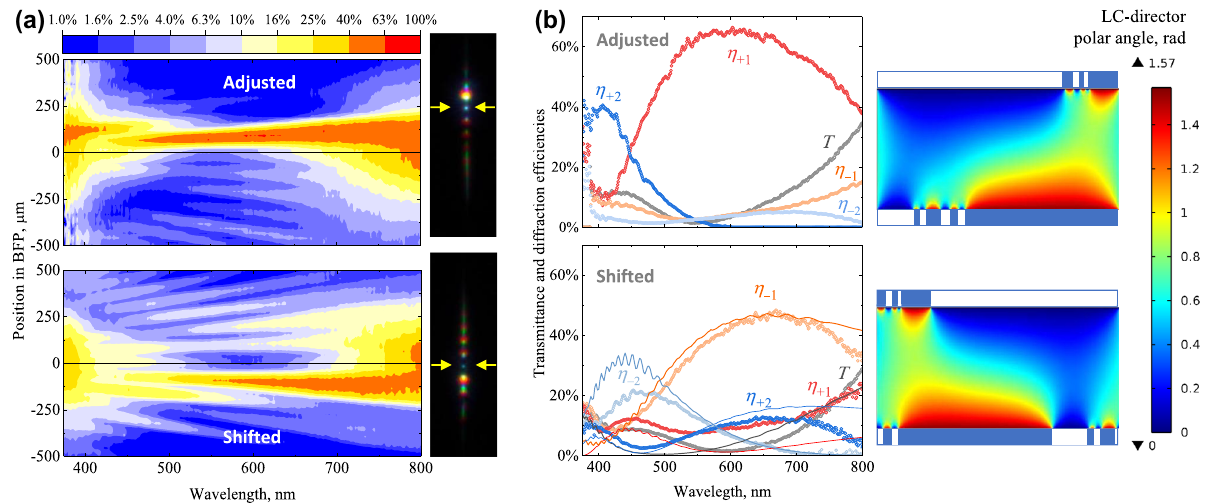
Figure 6: Mechanical tuning of the 8 μ m periodic double-sided LC-metasurface. (a) Intensity colormaps obtained by BFP spectrometry when the substrates are properly adjusted and shifted to yield the maximum intense spots of + 1 and − 1 diffraction orders correspondingly. In the BFP images shown on the right the 0-order spots of forward transmission are indicated by yellow arrows. (b) Spectra of transmittance and diffraction efficiencies extracted from the intensity colormaps (circles) with the best fit of the shifted configuration obtained by COMSOL simulations (solid lines) assuming a 4 μ m relative shift of the substrates. On the right: comparison of the corresponding distributions of the polar angle of LC director within one metasurface period when the substrates are exactly adjusted (same as in Figure 2(a)) and shifted by 4 μ m with the coordinate origin chosen for better comparison. The binary substrate aligning action is visualized as in Figure